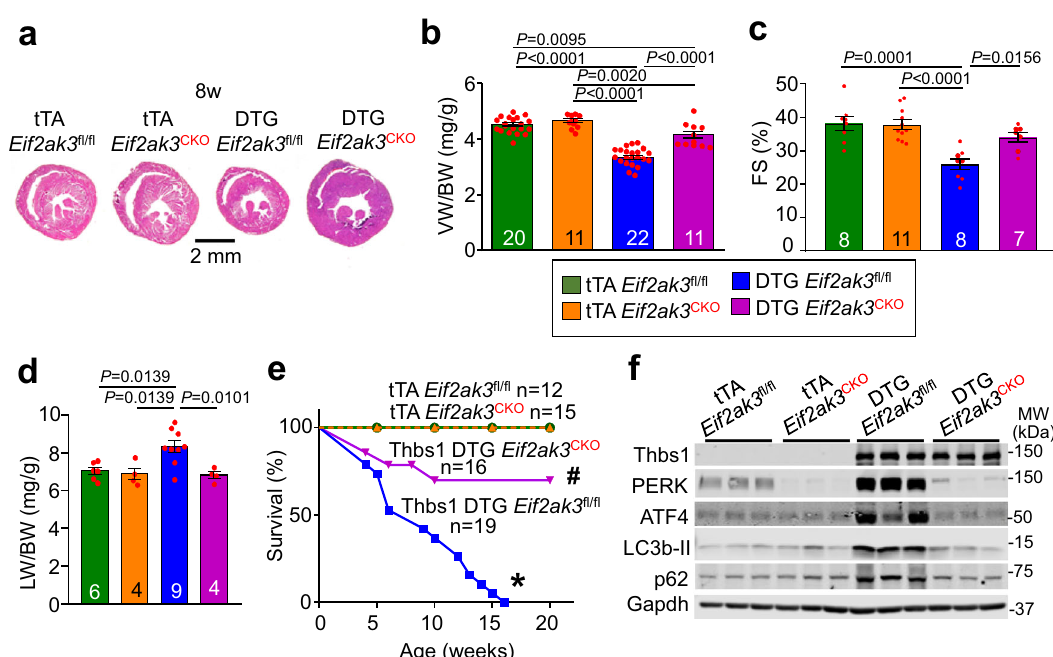
Fig. 7 Thbs1 induces PERK/ATF4 to facilitate cardiac atrophy. a Low magni fi cation cardiac histological images from tTA cont. Eif2ak3 fl / fl (PERK), tTA Eif2ak3 fl / fl β MHC-Cre ( Eif2ak3 CKO ), Thbs1 DTG Eif2ak3 fl / fl , and Thbs1 DTG Eif2ak3 CKO mice stained with Masson ’ s trichrome at 8 weeks of age. Scale bar is 2mm. b VW/BW ratio, c FS percentage and d LW/BW ratio at 8 weeks of age in the indicated groups of mice. The number of biologically independent animals analyzed and P -values are indicated on the graphs for panels “ b – d ” . Statistical analysis was performed using one-way ANOVA and Tukey multiple comparisons test for panels “ b – d ” . Error bars are ±standard error of the mean. e Kaplan – Meier survival plot from tTA cont. Eif2ak3 fl / fl , Thbs1 DTG Eif2ak3 fl / fl , tTA cont. Eif2ak3 CKO and Thbs1 DTG Eif2ak3 CKO . The number of biologically independent animals analyzed are indicated on the graph. Statistical analysis was performed using a two-tailed log-rank test. *P <0.0001 vs tTA cont. Eif2ak3 fl / fl , Eif2ak3 CKO and Thbs1 DTG Eif2ak3 CKO , # P = 0.0678 vs tTA cont. Eif2ak3 fl / fl , and # P = 0.0404 vs Eif2ak3 CKO . f Representative western blots for Thbs1, PERK, ATF4, LC3b, and p62 from cardiac protein extracts isolated from the groups shown at 8 weeks of age. Protein extracts were from dissociated adult mouse heart cardiomyocytes. Gapdh serves as a loading control. Source data are provided as a Source Data